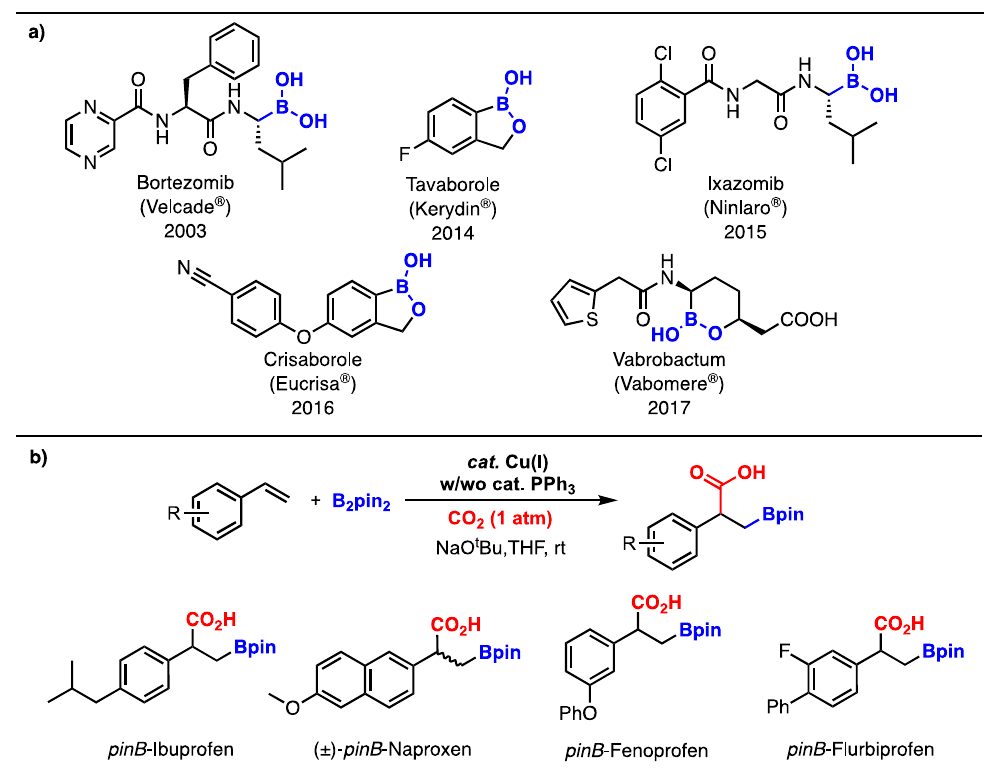
Figure 1. ( a ) United States Federal Drug Administration-approved boron-containing therapeutic drugs. ( b ) Boron-containing α -aryl propionic acid derivatives (pinB-NSAIDs) prepared via copper(I) catalysis.